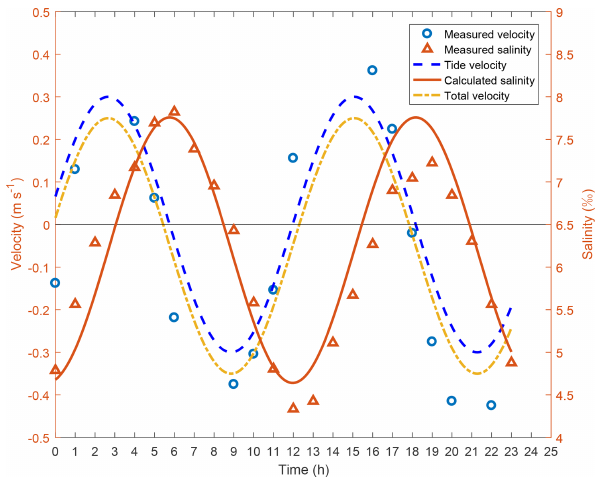
Figure 11. Salinity and tidal flow velocity over a tidal cycle at Huangpuyou station. The measured salinity is represented by tri- angles, and the measured flow velocity is indicated by circles (on 31 January 2005). The dashed line is the calculated tidal velocity, while the dashed–dotted line is the total velocity of tidal flow and river flow. The red solid curve represents salinity simulated by the unsteady analytical solution, which reproduces the time lag HWS and maximum salinity.